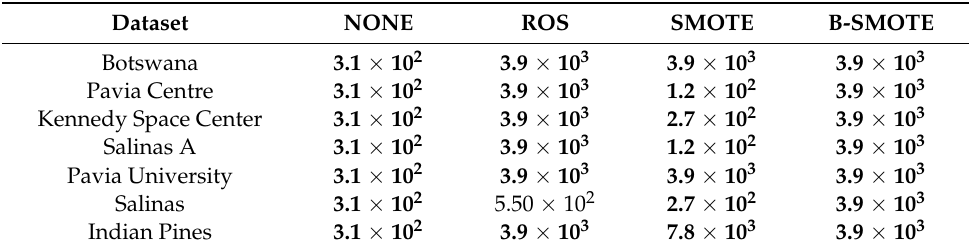
Table 5. p -values of the Wilcoxon signed-rank test. Boldface values are statistically significant at a significance level of α =